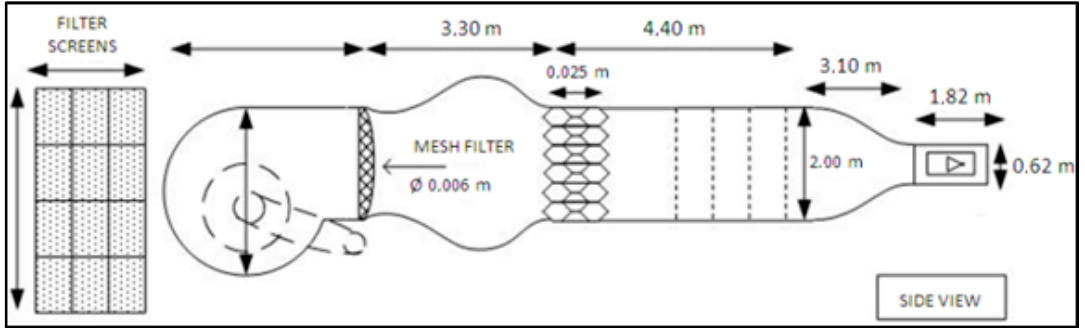
Figure 13. Dimensions of the Price–Païdoussis subsonic wind tunnel.